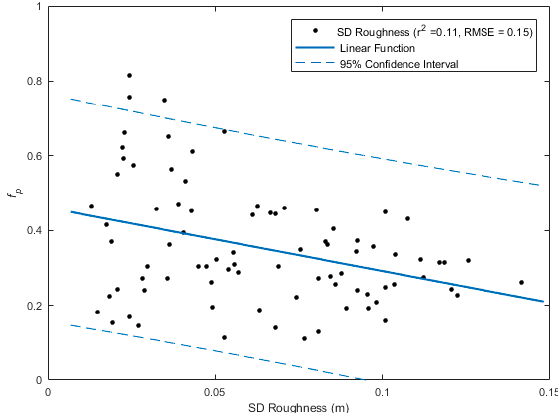
Figure 10. Linear OLS model of f p as a function of standard deviation of roughness. The data was aggregated using the hybrid-based approach at the medium scale. A linear function has been fitted to the data (solid blue line), with a 95% confidence interval (dashed blue line).